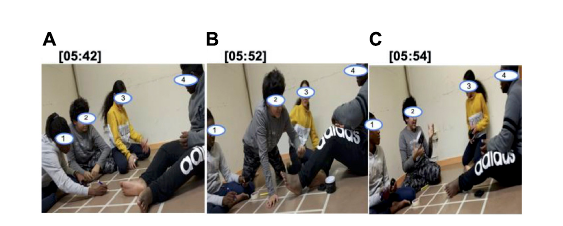
FIGURE4 Example of shared exploration (A–C) . (A) Participant 1 is focused on her (non-shared) graphical activity. Participant 2 is paying attention to what participant 4 is doing, who is himself trying to get into interaction with participant 3. The latter seems to enjoy exploring, and no personal or shared game is elaborated enough to be identifiable. (B) Participant 1 didn’t cease her non-shared activity. Participant 2 intervenes in the interaction between 3 and 4, reaching for the round box. (C) Participant 1 ceases her private activity. All 4 participants are in a moment of joint attention.